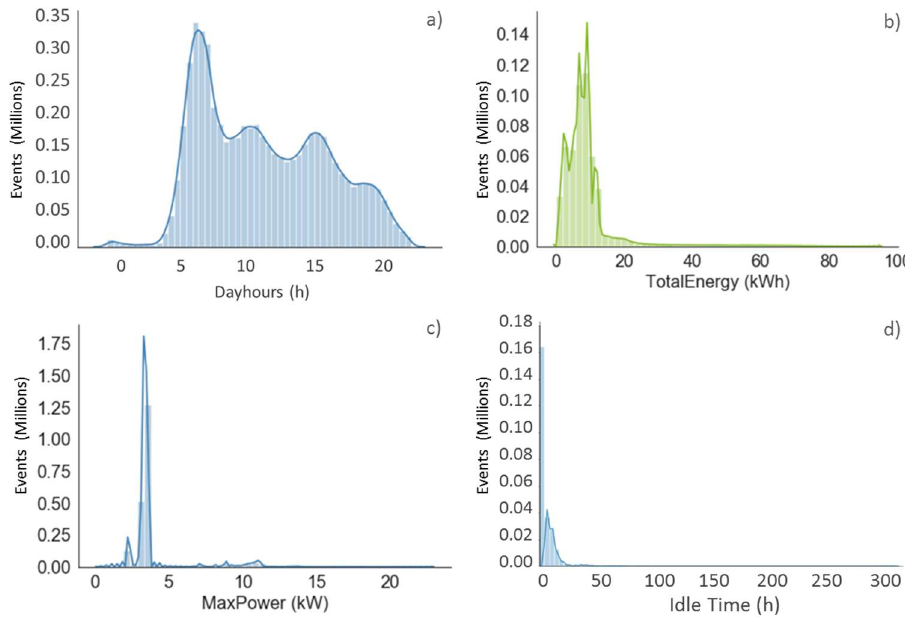
Figure 2. Histogram of sessions by ( a ) intraday time (sec), ( b ) total energy (kWh), ( c ) maximum power supplied (kW) and ( d ) idle times observed in the data set.